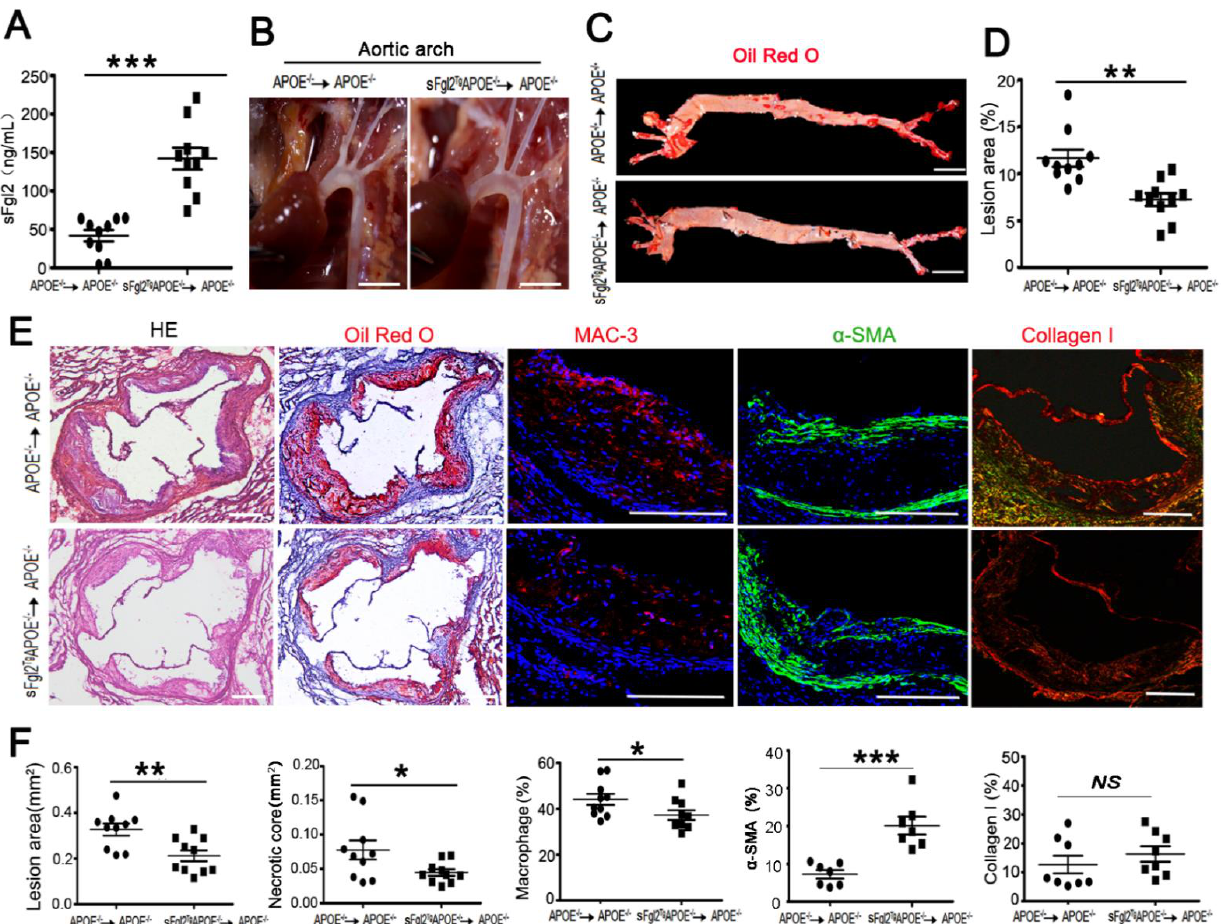
Figure 5. Over-expression of bone-marrow-derived sFgl2 could affect cellular plaque composition and attenuate atherosclerosis in mice. ( A ) The expression level of sFgl2 in irradiated ApoE -/- mice reconstituted with sFgl2 Tg ApoE -/- or ApoE -/- bone marrow was detected by Elisa. ( B ) Aortic arch lesion area in two groups. Scale bar = 2 mm. ( C ) Oil Red O staining of the aorta en face lesion area. Scale bar = 5 mm. ( D ) Quantification of relative lesions area of full-length aorta. ( E ) Representative photomicrographs showing HE, Oil Red O, MAC 3, α -SMA, and collagen I stained area in cross- sections of the aortic root. Scale bar = 200 μm. ( F ) Quantifications results of HE, Oil Red O, Mac-3, α -SMA, and collagenI. NS = Not significant, * p < 0.05, ** p < 0.01, *** p < 0.001. Data were represented as mean ± SEM.